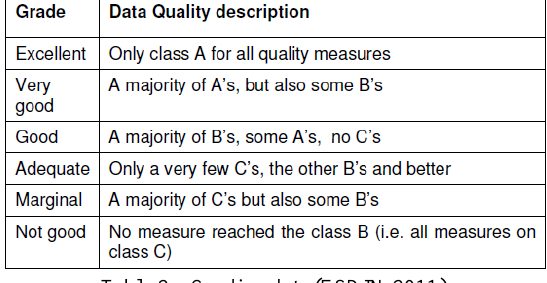
Table 2. Grading data (ESDIN